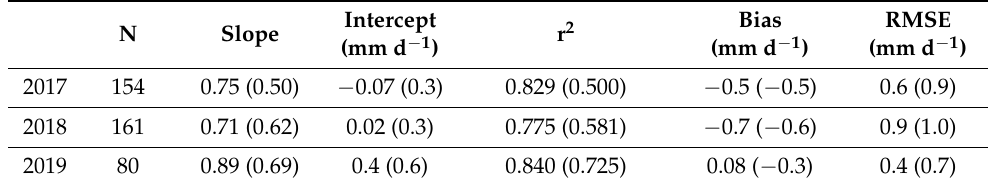
Table 3. Statistical analysis of the comparisons shown in Figure 7. Results corresponding to the comparison with direct EC measurements (not corrected) are shown in brackets.